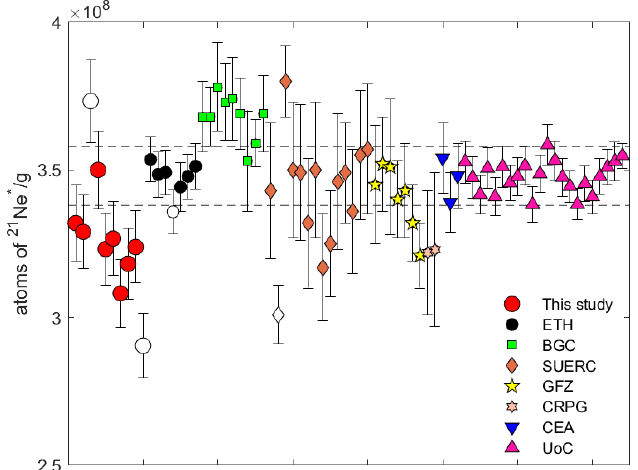
Figure 8. Cosmogenic 21 Ne in CREU-1 quartz measured using the ARGUS VI mass spectrometer. Mean value (3.25 ± 0.12 × 10 8 21 Ne * atoms/g, n = 8, 2 outliers) was lower by 6.6% than the accepted standard value (dashed line, 348 ± 10 × 10 8 21 Ne * atoms/g) but it overlapped it within 2 σ . Data are after Refs. [5,24,25] . ETH (Switzerland), BGC (USA), SUERC (Scotland), GFZ (Germany), CRPG (France): CEA: China Earthquake Administration (PR China), UoC: University of Cologne (Ger- many). 2 sigma uncertainties are plotted. Empty: outlier.